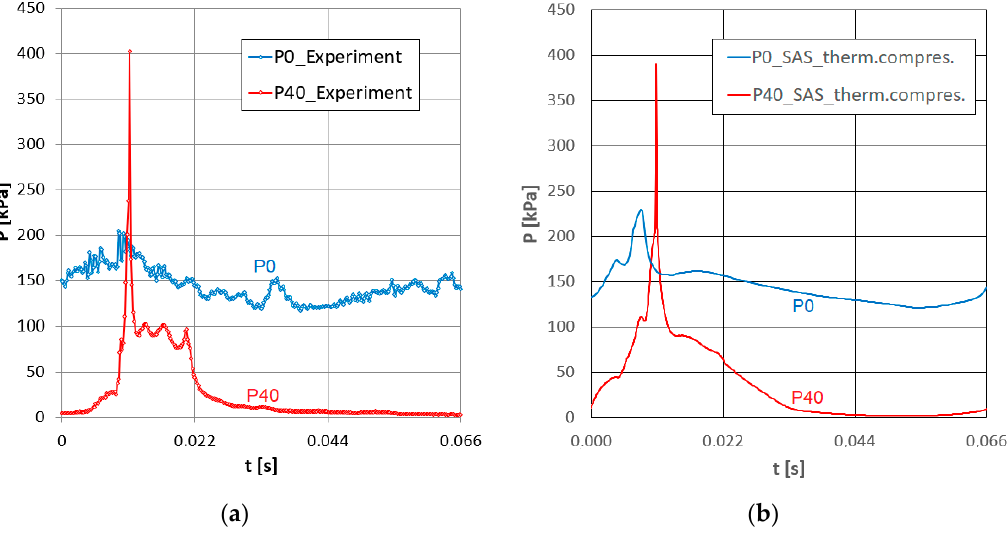
Figure 29. Pressure pulse during one shedding cycle in positions P0 and P40. ( a ) Experiment; ( b ) numerical simulation employing real properties of fluids.